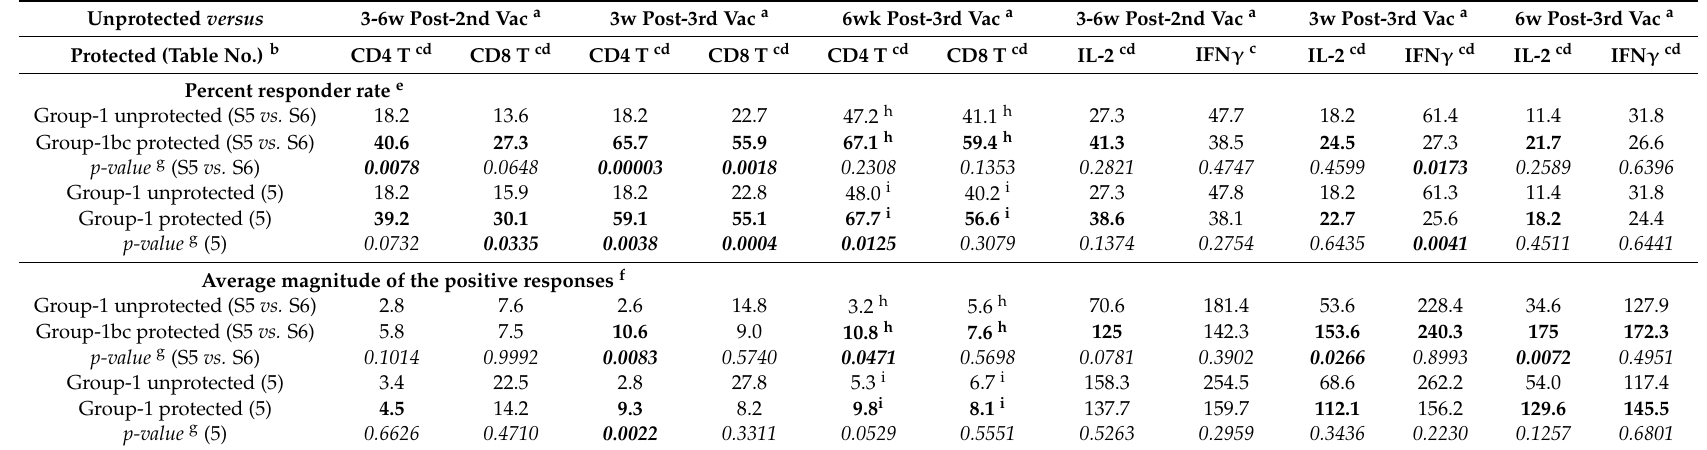
Table 4. Statistical comparison between unprotected/vaccinated cats and protected/vaccinated cats from Group 1bc or from all vaccine groups. Unprotected